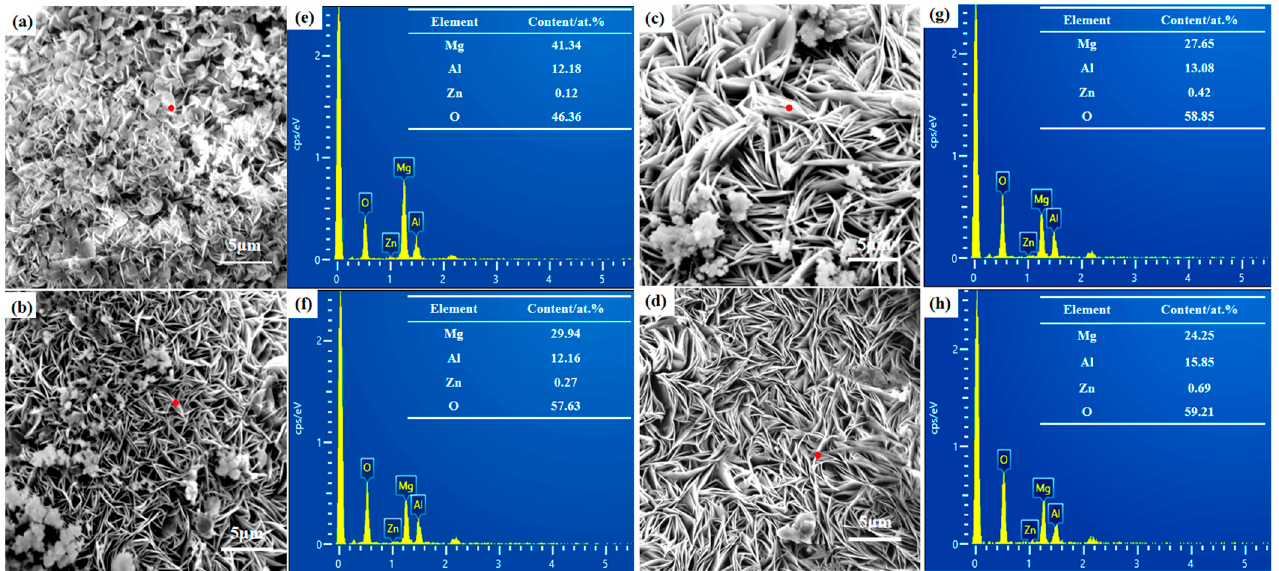
Figure 2. SEM surface micrographs and EDS analysis of ZnAl-LDH films grown on AZ91D Mg alloy with different surface roughness: ( a , e ) 600; ( b , f ) 1200; ( c , g ) 2000; and ( d , h ) 5000.